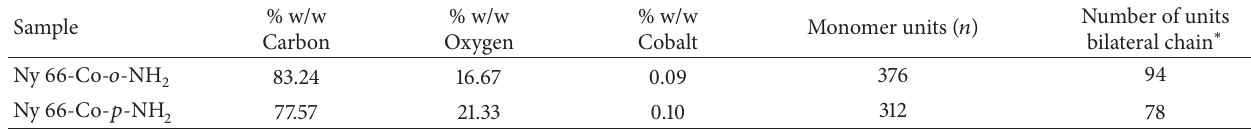
∗ Lateral chains are formed by 𝑎 , 𝑏 , 𝑐 , or 𝑑 units rendering a total of 𝑛 units in each